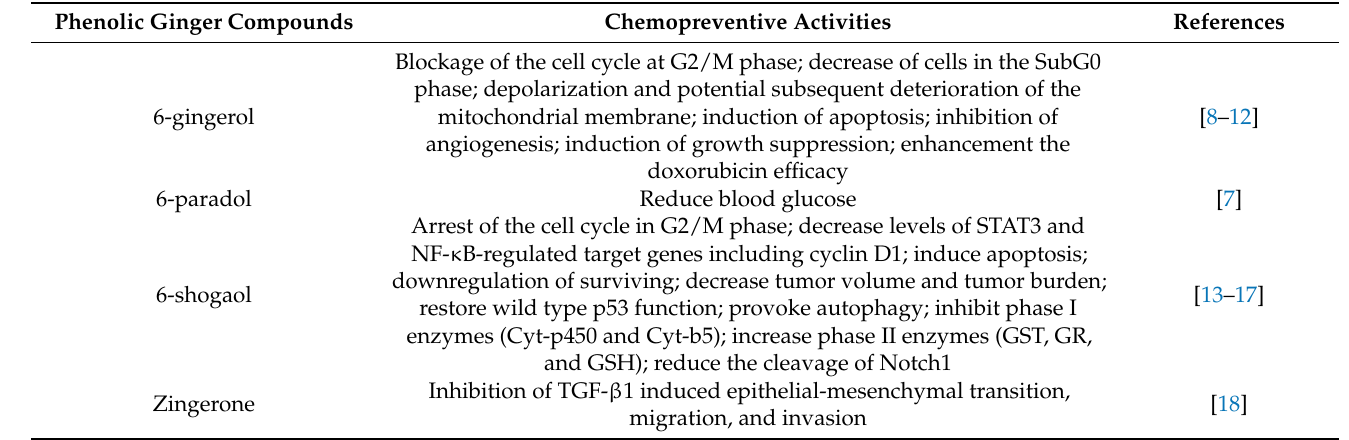
Table 1. Chemopreventive activities of phenolic compounds of ginger.